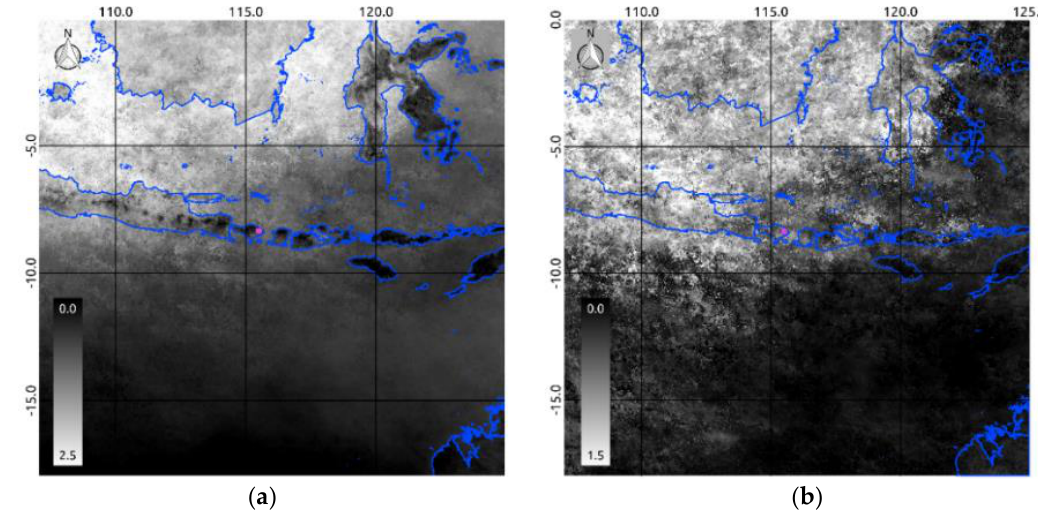
Figure 2. Temporal mean ( a ) and standard deviation of ( b ) images of BT 10.4 ( x , y , t ) − BT 11.2 ( x , y , t ) in reference to November and to the time slot of 00:00 UTC. In pink, the location of Mt. Agung; in blue, the coastlines.